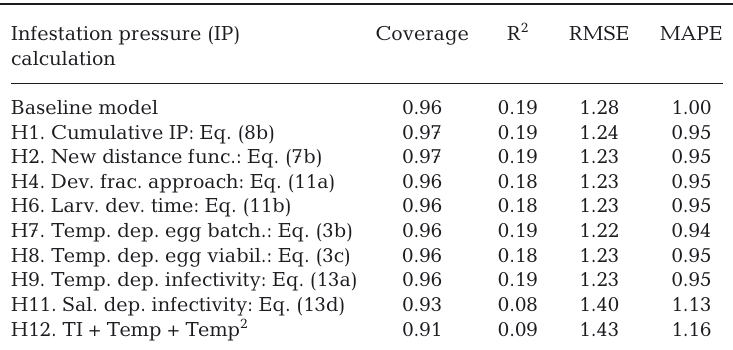
in life. The corrections for temperature-dependent egg viability (i.e. the difference in infestation pres- Table 3. Out-of-sample predictive power for salmon lice infestations in 2018− 2020 (n = 298 sentinel cages). Coverage is the proportion of observations within the 95% prediction interval. Variance explained (R 2 ), root-mean-squared pre- diction error (RMSE) and mean absolute prediction error (MAPE) were calcu- lated based on mean observed and predicted lice per cage at the scale ln(lice per cage + 0.033). TI: total infestation